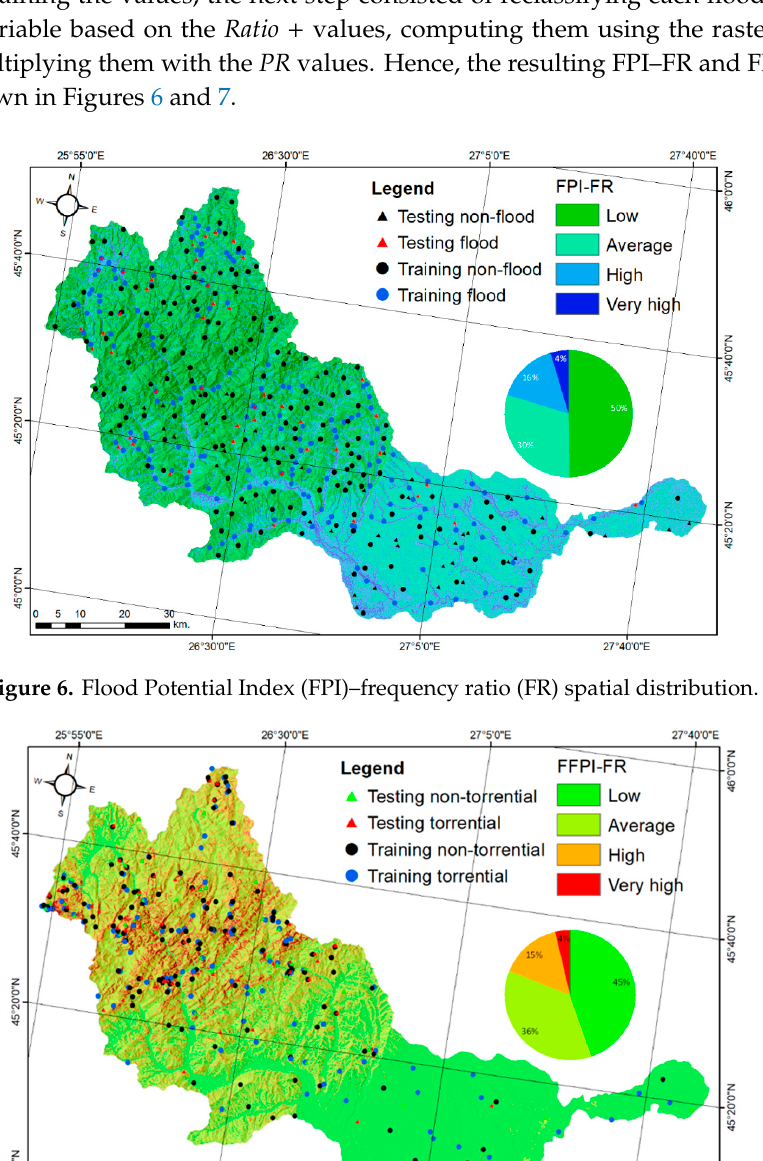
Figure 5. Multilayer perceptron neural network diagram.